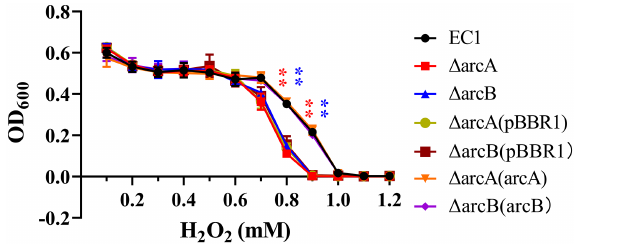
FIGURE 2 The deletion mutant of arcA and arcB enhanced the sensitivity to hydrogen peroxide. Both strain EC1, mutants D arcA, D arcB, D arcA(pBBR1) and D arcB(pBBR1), complemented strains D arcA(arcA) and D arcB(arcB) were inoculated in LB medium containing different fi nal levels of H indicated and measured at 600 nm using a microplate reader (BioTek). Three independent experiments were performed in triplicate. ** p < 0.01, Student ’ s t